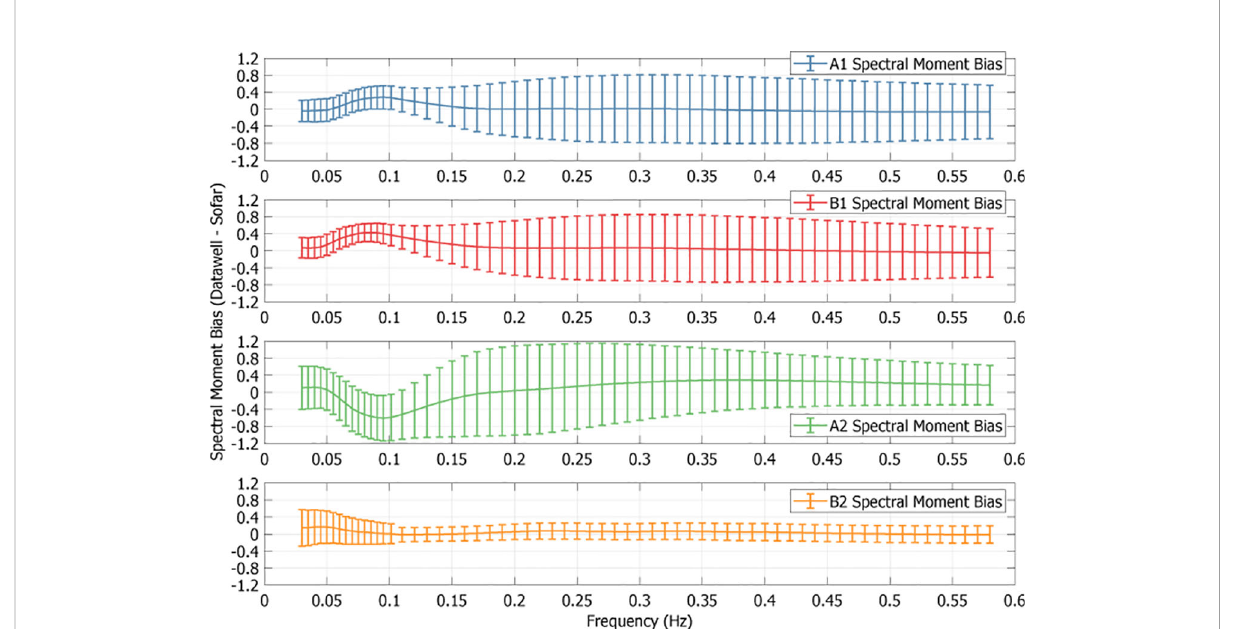
FIGURE 11 Biases of each spectral moment between the two wave buoys for each frequency band during the duration of the study. The error bars show the bias standard deviation for the spectral moments in each frequency band.